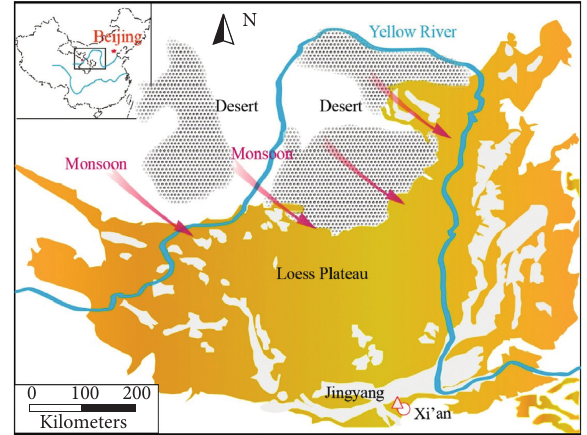
Figure 1: Loess area of China (adapted from Hou et al. [14]).